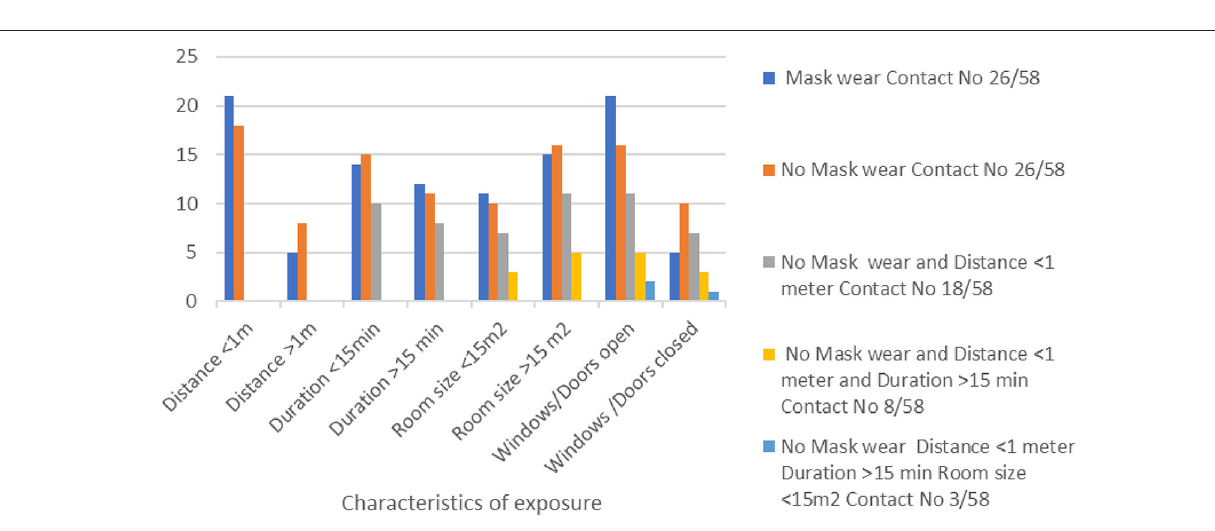
FIGURE 2 | Characteristics of the contact of healthcare workers ( N = 58) with three patients with SARS-CoV-2 in a regional hospital in Greece at the beginning of the COVID-19